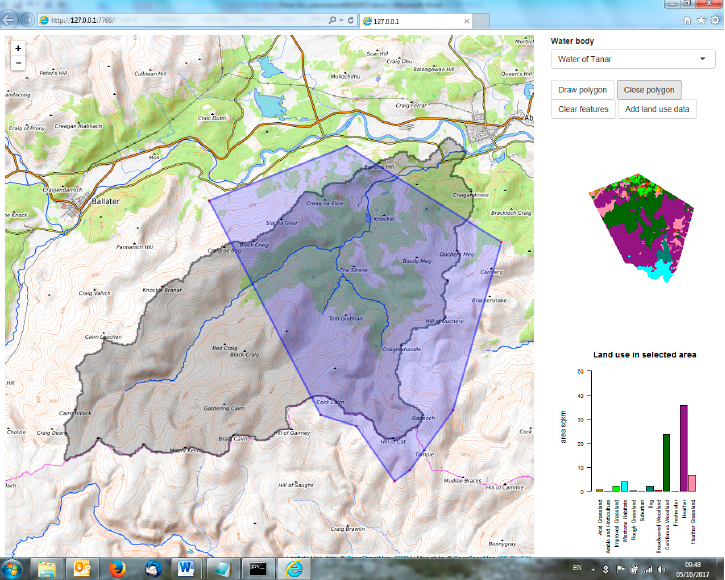
Figure 3. Prototype application running on Windows. The screen capture shows the Water of Tanar sub-catchment of the river Dee in Aberdeenshire, Scotland. The user has drawn a polygon, which has been clipped out of the land use base map (LCM2007) and is displayed in the box to the right of the map window. Below it, the area of each land use in the polygon is displayed as a histogram.